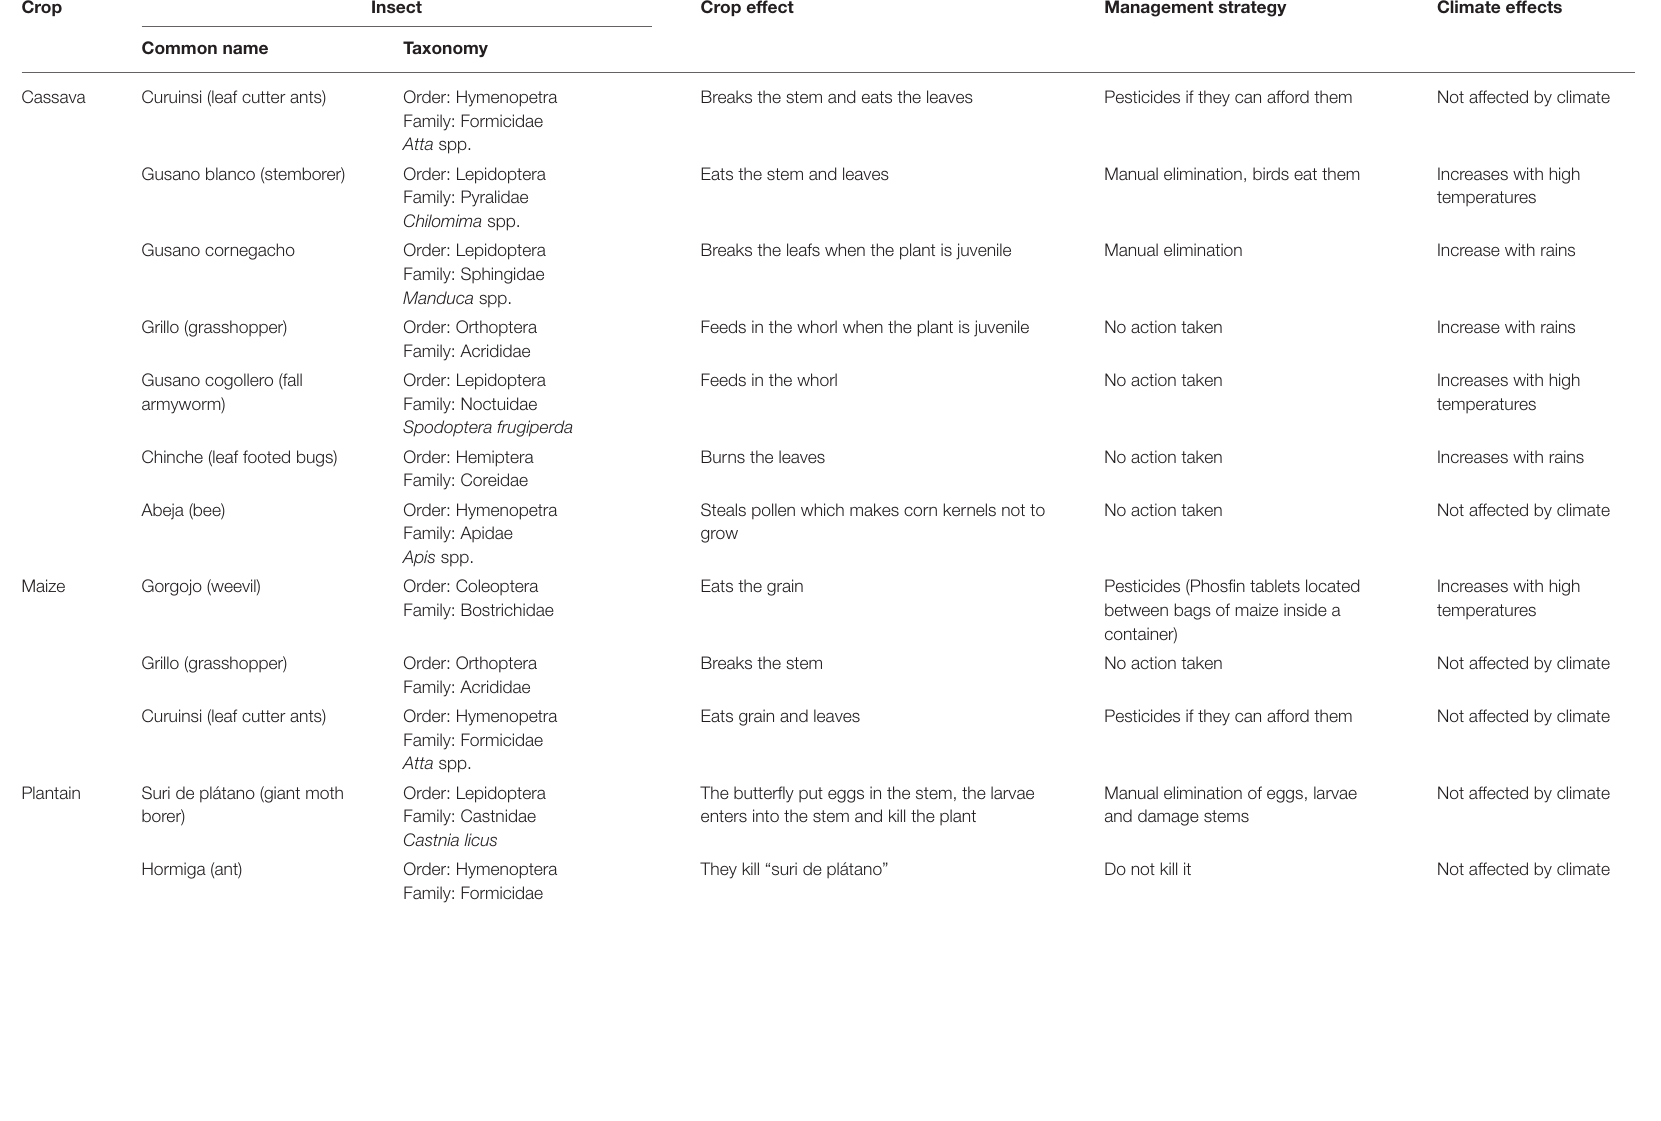
TABLE 4 | Practical knowledge of common management strategies associated with entomofauna among women.